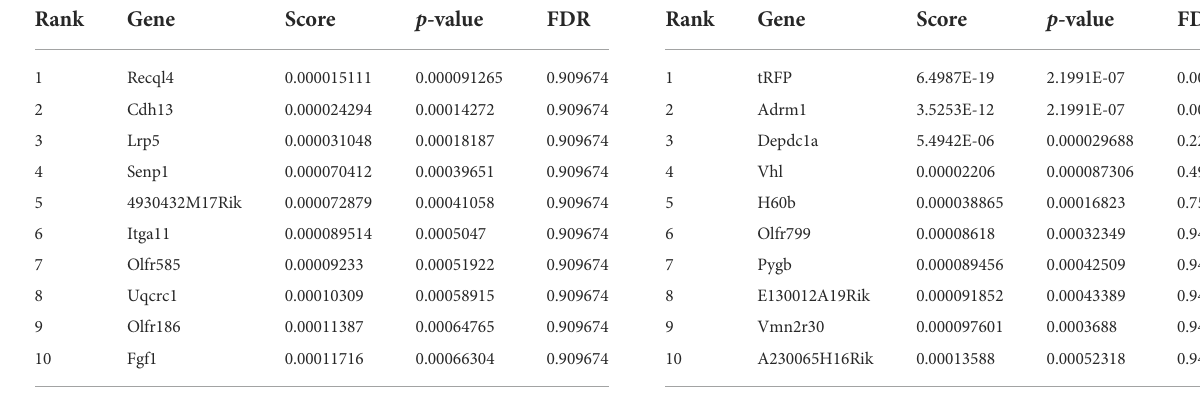
TABLE 1 Genes enriched in Both Down.